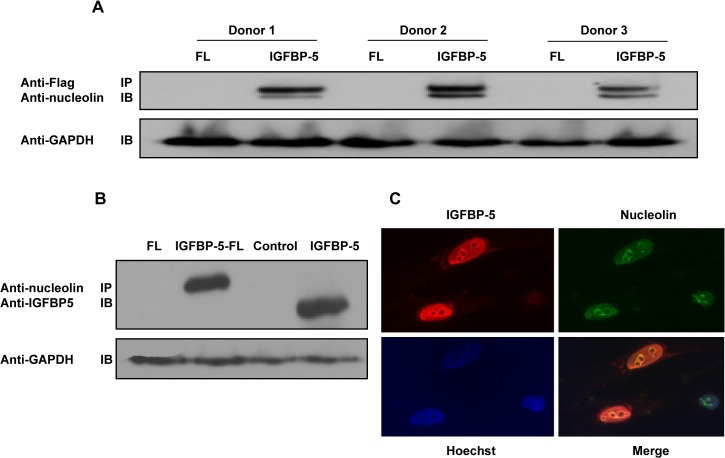
Nucleolin is an IGFBP-5 binding partner.Following identification of nucleolin using mass spectrometry, interaction with IGFBP-5 was confirmed using co-precipitation. (A) Wild type IGFBP-5 binds nucleolin in fibroblasts from three different donors. (B) Reverse pull-down with nucleolin antibody confirms the interaction with IGFBP-5. GAPDH in input lysate was detected to confirm that lysate fractions with equivalent protein levels were used for the IP. (C) Co-localization of nucleolin and IGFBP-5 is detected using immunofluorescence (IGFBP-5: red; nucleolin: green).